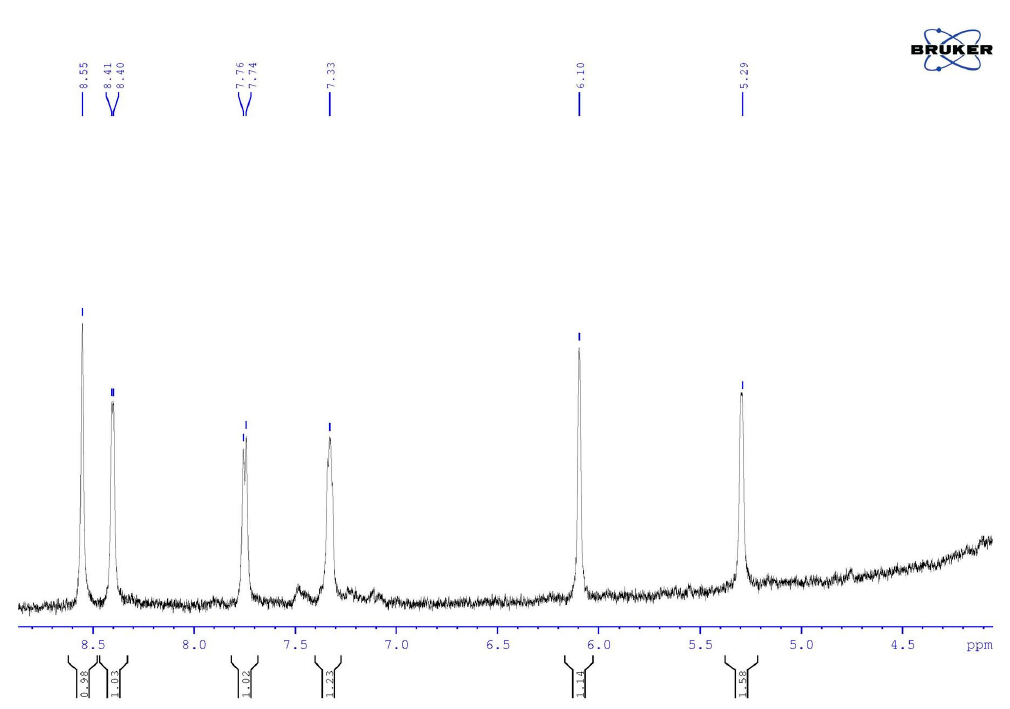
Figure 11. A diagnostic fragment of the NMR spectrum of the abiraterone nanoparticles.